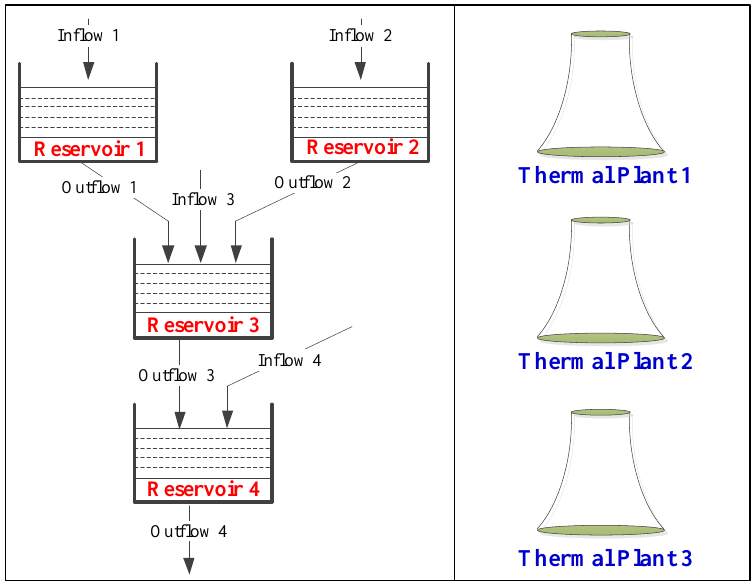
Figure 5. Schematic map of the test hydrothermal system.